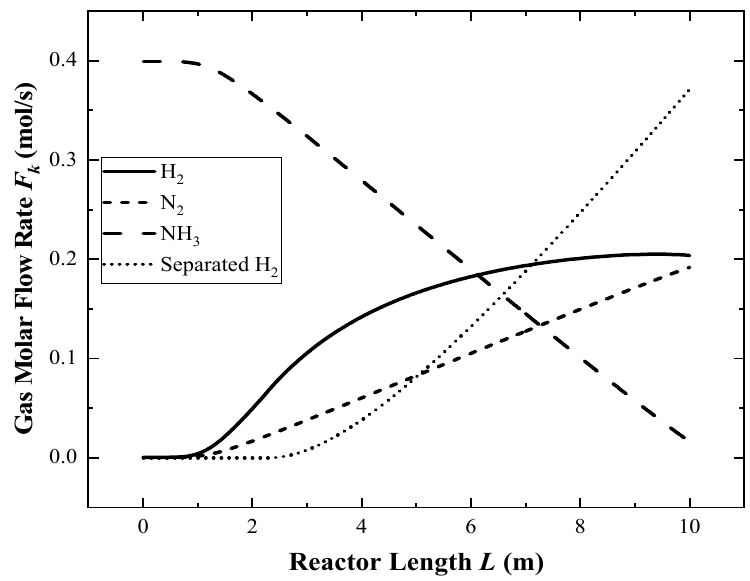
Figure 3. The distributions of each component flow rate along the reactor.